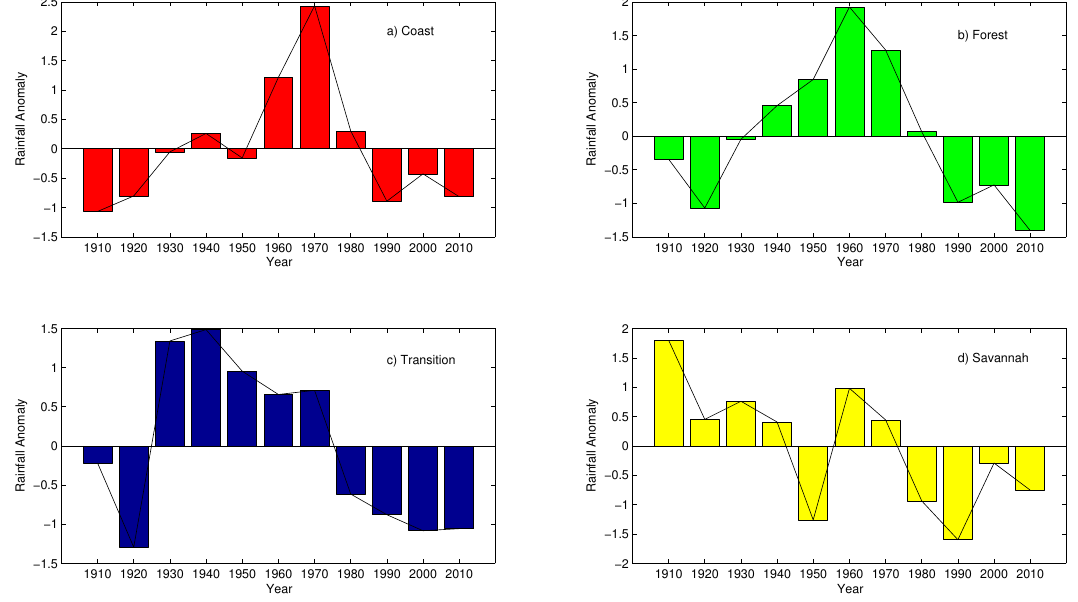
Figure 11. ( a – d ) Decadal anomaly of rainfall over the agro-ecological zones of